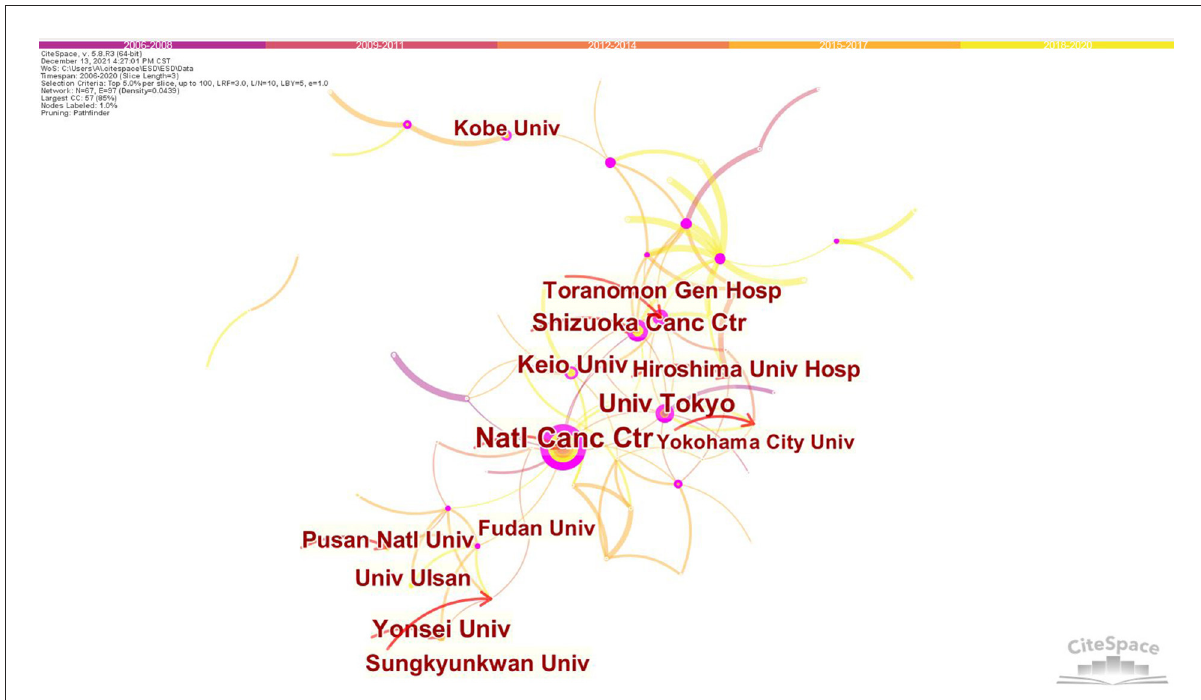
FIGURE3 Map of institutes cooperative relations in research of ESD, 2006-2020. The bigger the circle, the more original articles the institute published. The shorter and thicker the connection line, the closer the relationship between institutes.